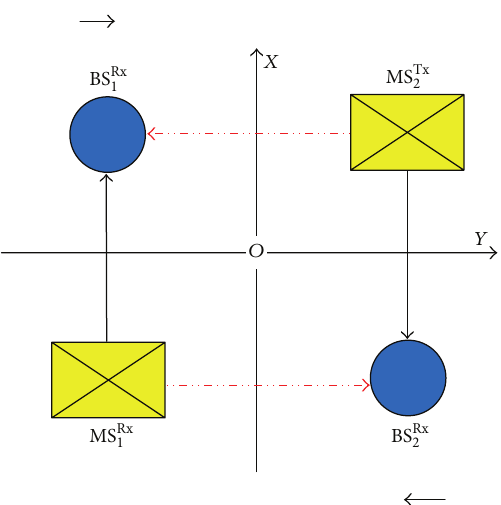
Figure 5: A simple circumstance for single-hop ad hoc network.